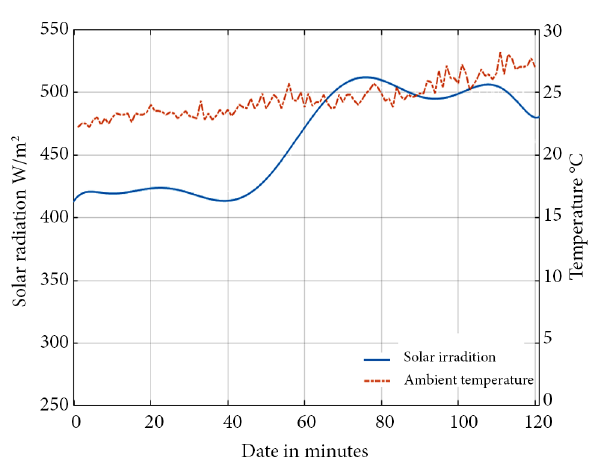
Figure 4. Variation of the recorded solar radiation and Ambient Temperature on Nov 2 nd 2018